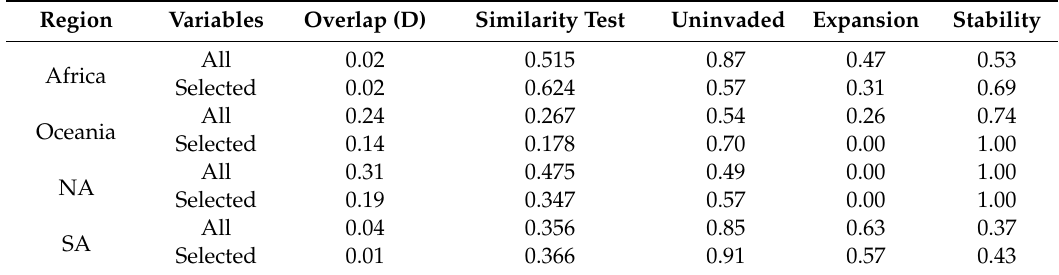
Figure 3. Native and invasive climatic niches of ALB in different regions along with variable factor maps. Multivariate climatic space was calculated using the PCA-env method. Results using all variables are shown in parts ( a ) and ( b ), whereas parts ( c ) and ( d ) shows the results obtained with selected variables. The solid and dashed lines delineate the niche occupied by the 50% densest population and all available climatic niche, respectively. Shadings correspond to the density of occurrences in each region: Asia (green, native), Europe (red, non-native), and North America (blue, non-native), respectively. The variance explained by the PC1 and PC2 is 74.27% for all variables and 90.10% for selected variables. Table 2. Summary of p values for the niche test of Sirex Woodwasp between native range Eurasia (EUA) and invasive ranges Africa, Oceania, North America (NA), and South America (SA) using all and selected climatic